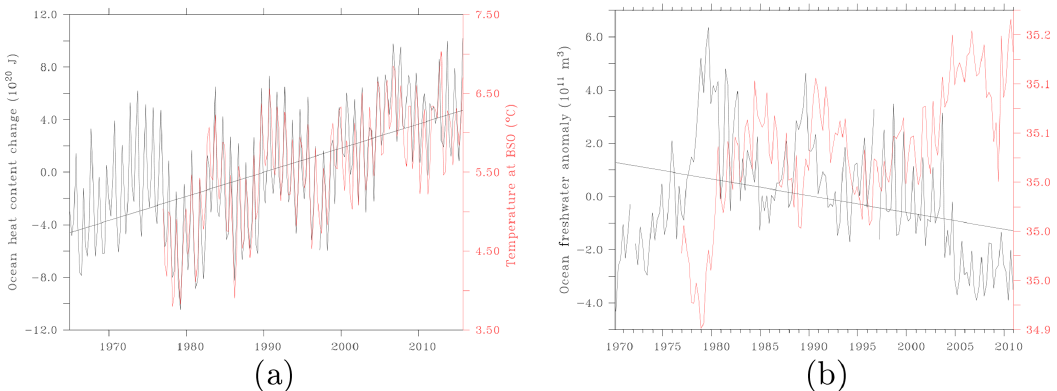
Figure 13. (a) Ocean heat content in the most reliable area between 1965 and 2015, its linear trend (black), and temperature at the Barents Sea Opening. (b) Equivalent freshwater content in the most reliable area between 1970 and 2010, its linear trend (black), and salinity at the Barents Sea